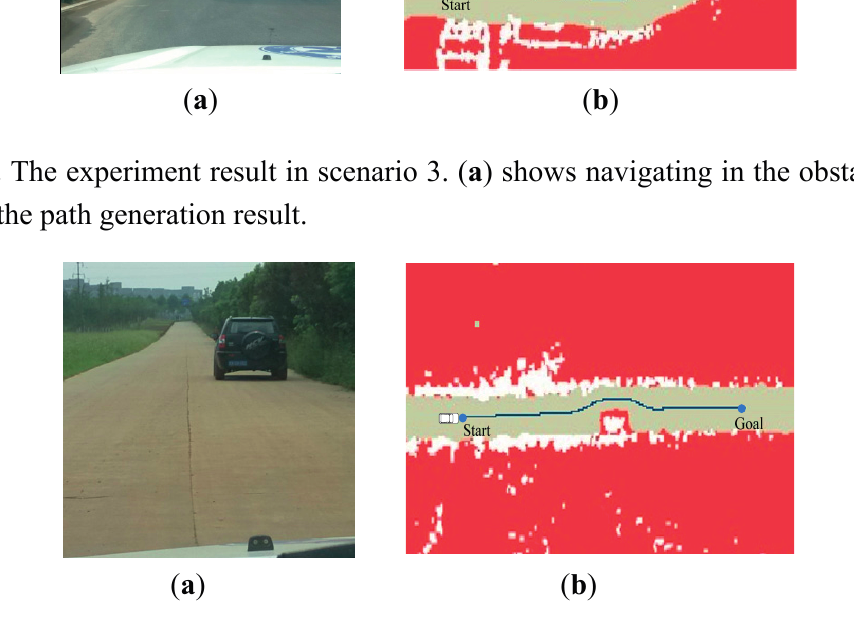
Figure 13. The experiment result in scenario 4. ( a ) shows navigating in the obstacle field; ( b ) shows the path generation